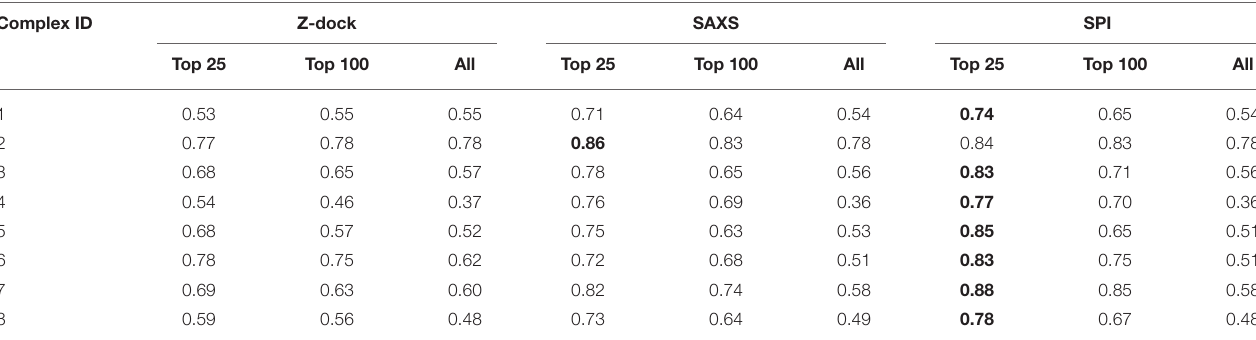
TABLE 2 | The performance of scoring functions. Complex